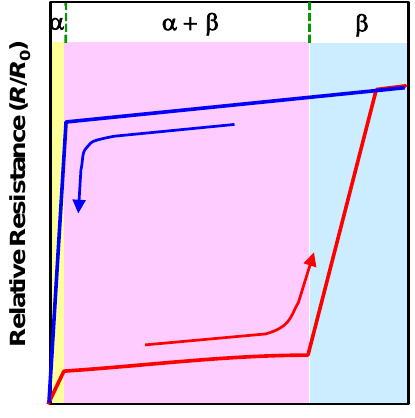
Figure 1. Schematic illustration of relative resistance ( R / R hydrogen concentration (H/Pd) for absorption-desorption processes. The arrows indicate the directions of absorption and desorption